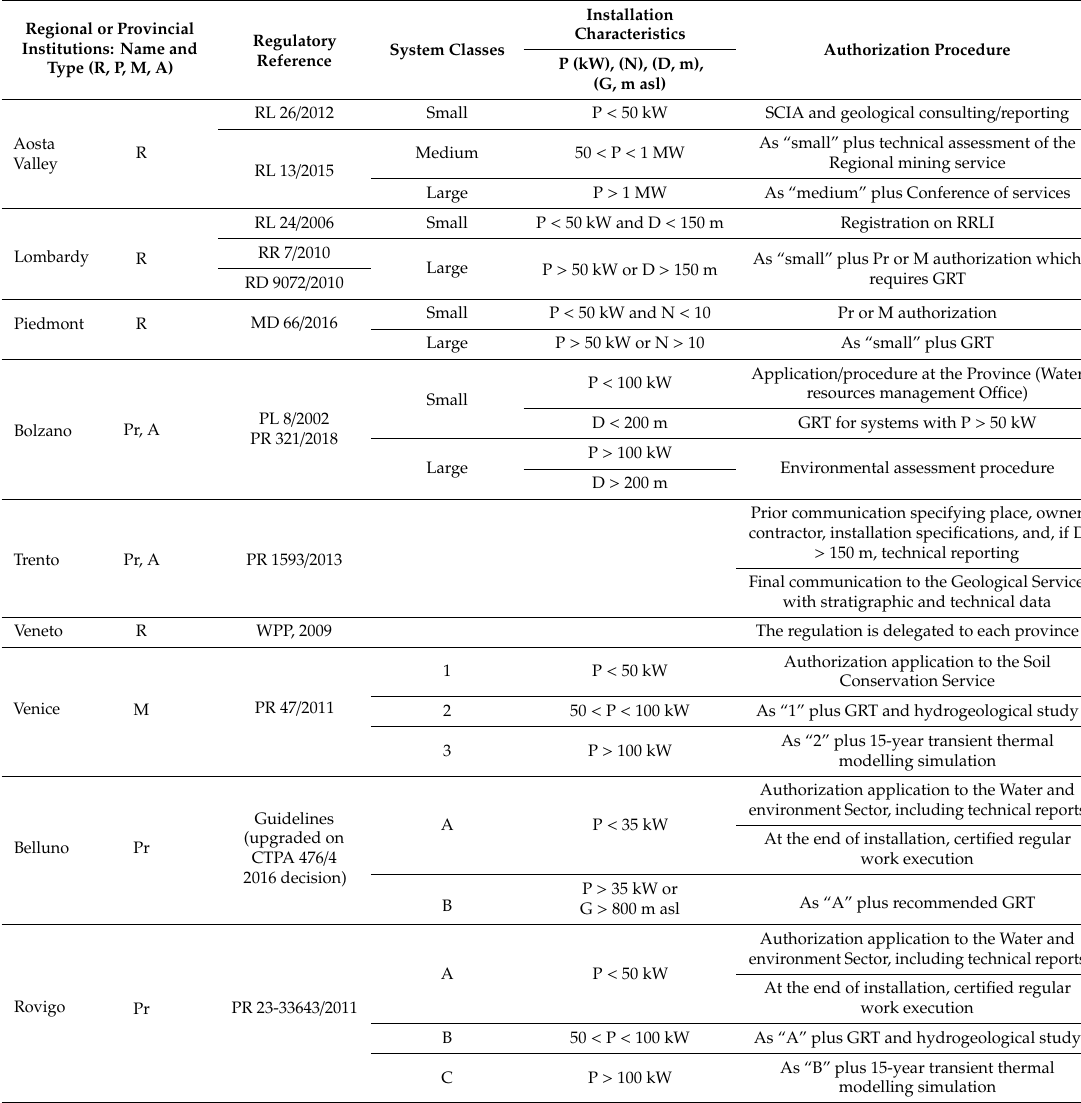
Table 2. Italian framework of local LEG regulations. Institutions: R = region; Pr = province or M = metropolitan town (a recent regulation for the main national towns which includes the whole province); A = autonomous (which is a special autonomous status for some region or province). Reference: RL = regional law; RR = regional regulation; RD = regional decree; RCD = regional council decree; MD = management decree; PL = provincial law; PR = provincial resolution; WPP = water protection plan. Installation: P = heating or cooling power; D = probe depth or length; N =